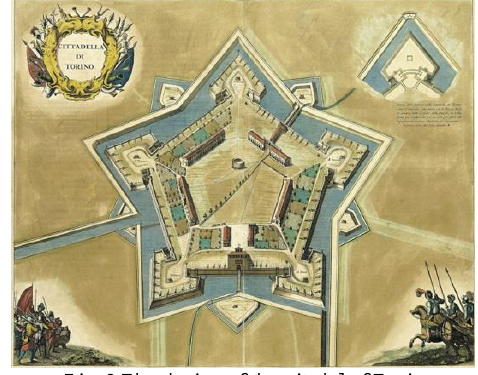
Fig. 8 The design of the citadel of Turin